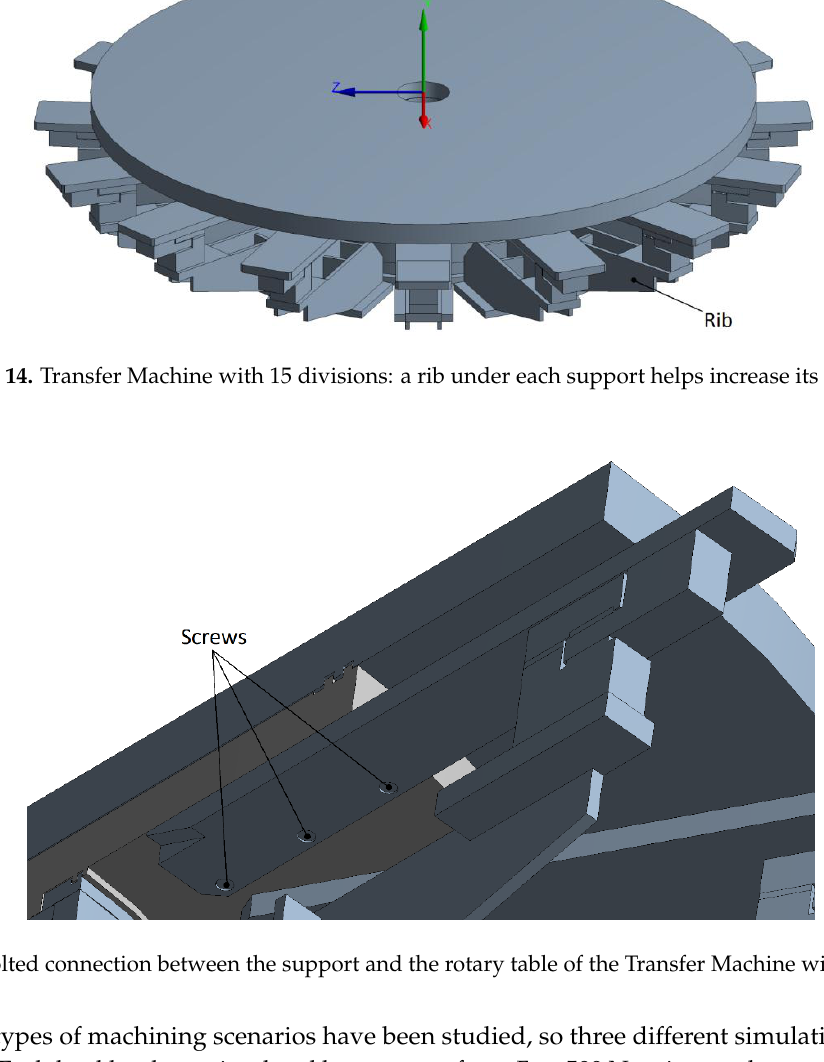
Figure 14. Transfer Machine with 15 divisions: a rib under each support helps increase its stiffness.